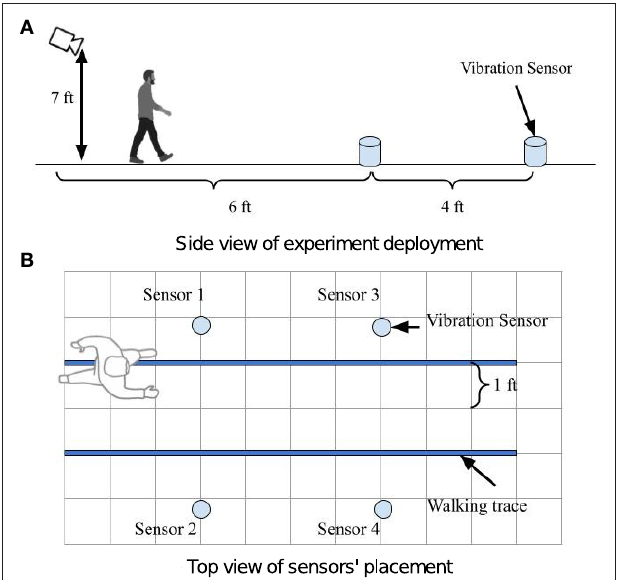
FIGURE 5 | Experiment deployment illustration. A camera is deployed 6 ft away from the sensing area as shown in (A) . Four vibration sensors are deployed in the sensing area 4 ft apart as shown in (B) . The blue lines in (B) depict walking traces of the pedestrian.